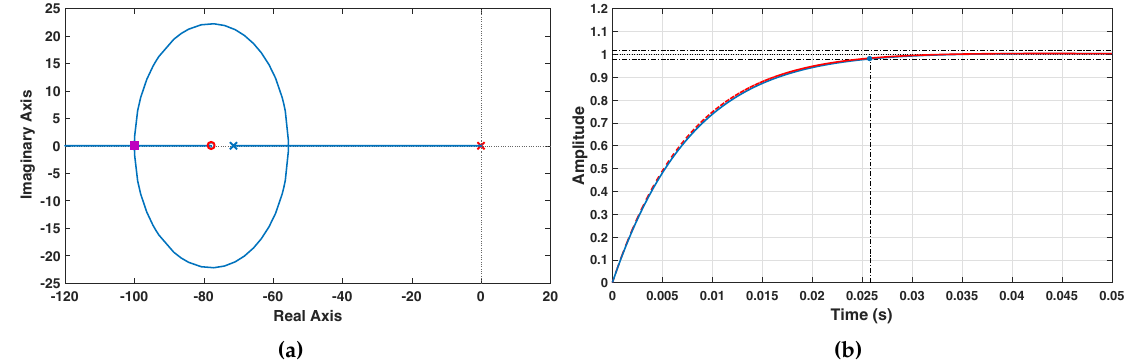
Figure 11. ( a ) location of the poles of the closed-loop system for the control of the battery current i b ; ( b ) time response of the battery current i b without considering the filter H b ( s ) (blue) and including the filter (red).